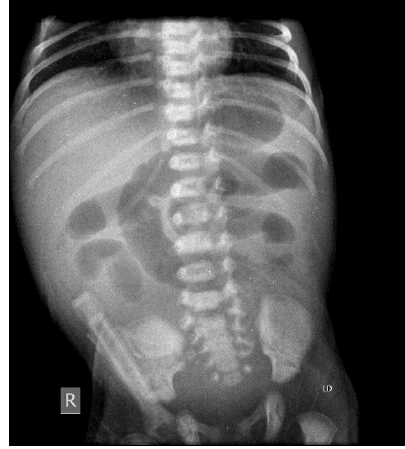
Figure 1: X-ray abdomen showing features of small intestinal obstruction